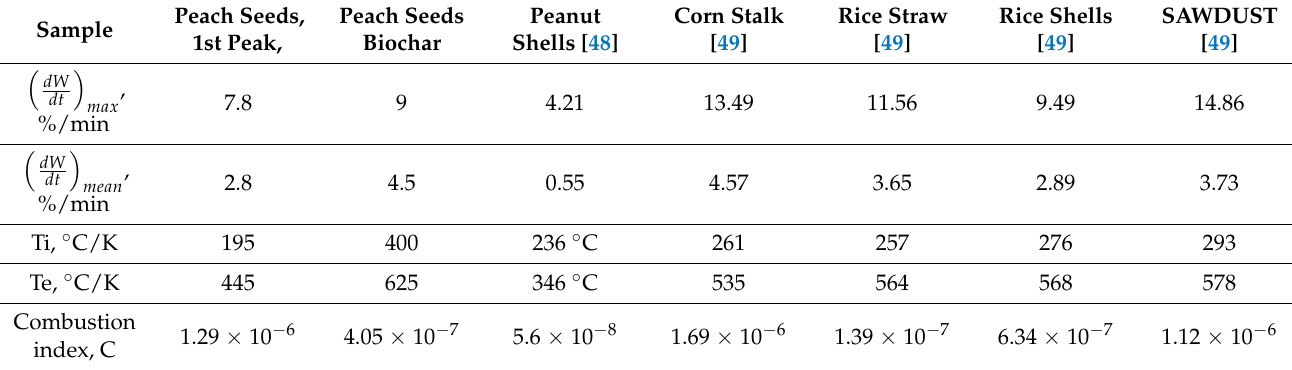
Table 9. Combustion index C of pretreated peach seeds, biochar and of different biomasses under a heating rate of 20 ◦ C/min.